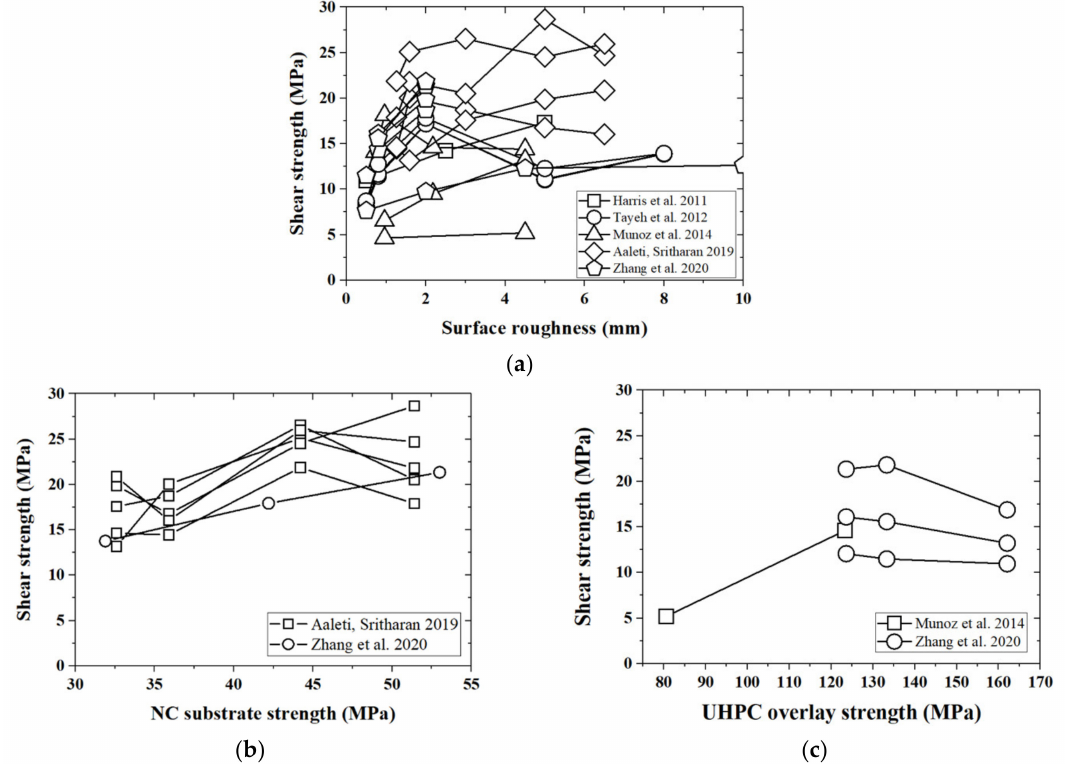
Figure 4. Relationships between shear strength and different factors in the slant shear test. ( a ) Shear strength and surface roughness; ( b ) shear strength and NC strength; ( c ) shear strength and UHPC